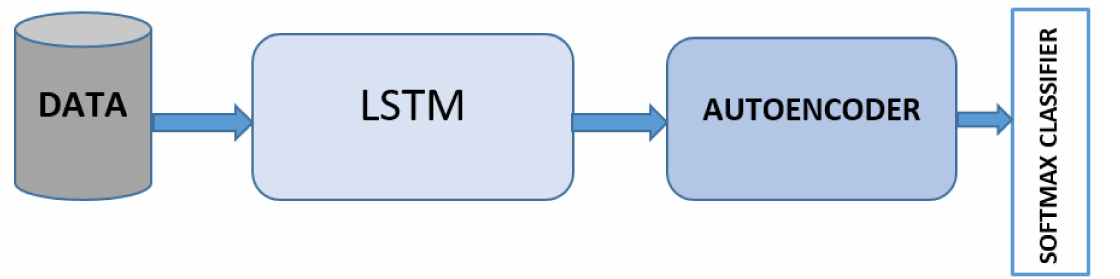
Figure 5. Illustration of components of an autoencoder.